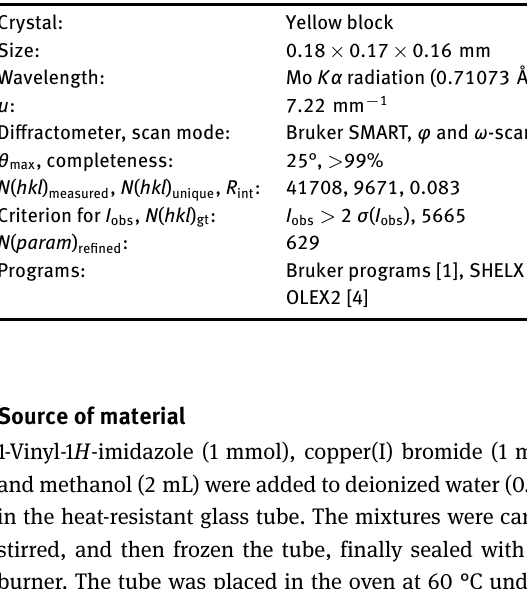
Table 1: Data collection and